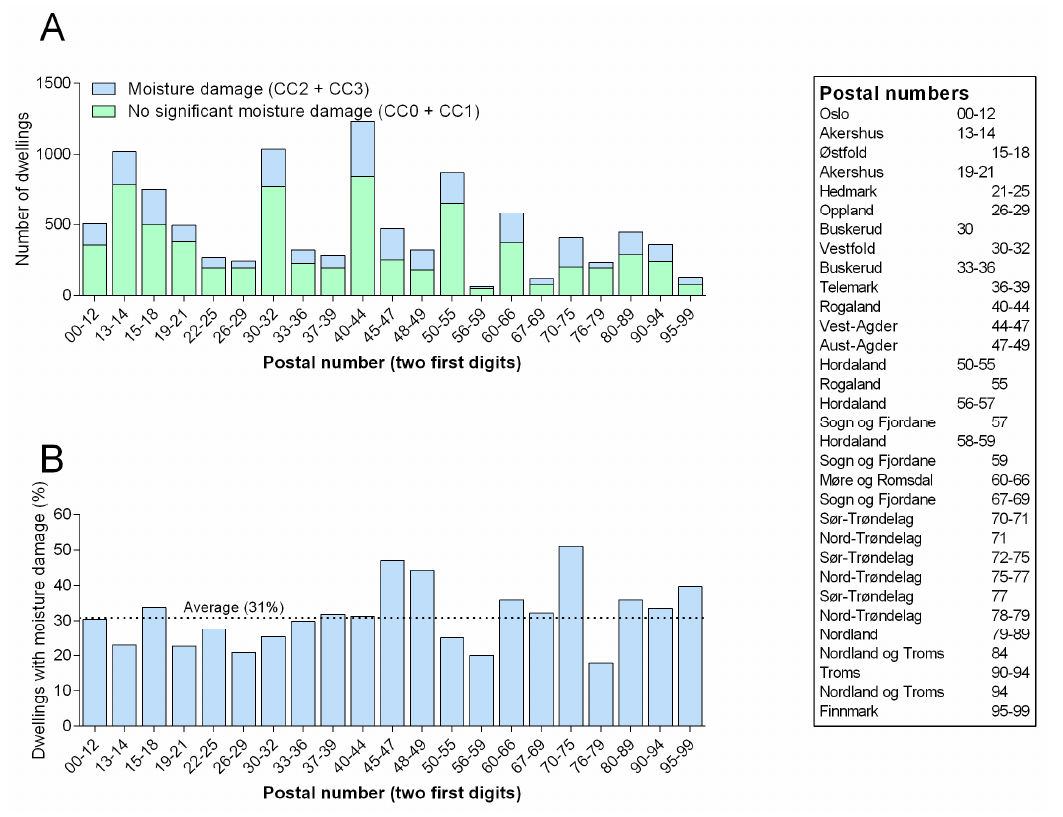
Figure 3. Dwellings with moisture damage distributed by geographical location. The figure shows total number of Norwegian dwellings in this study with and without moisture damage ( A ) and share of dwellings with moisture damage grouped after location/postal code ( B